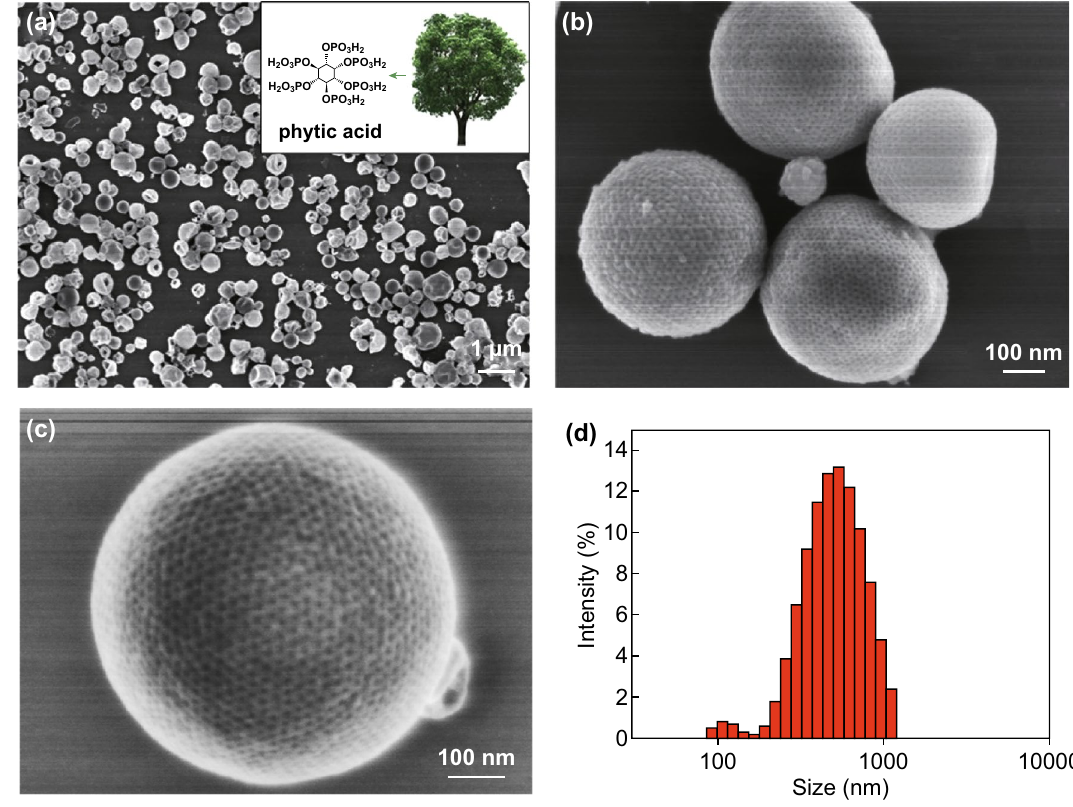
Fig. 1 Morphology of mFePA-HS. a – c SEM images of mFePA-HS at different magnifications. d The particle size distribution of mFePA-HS measured by dynamic light